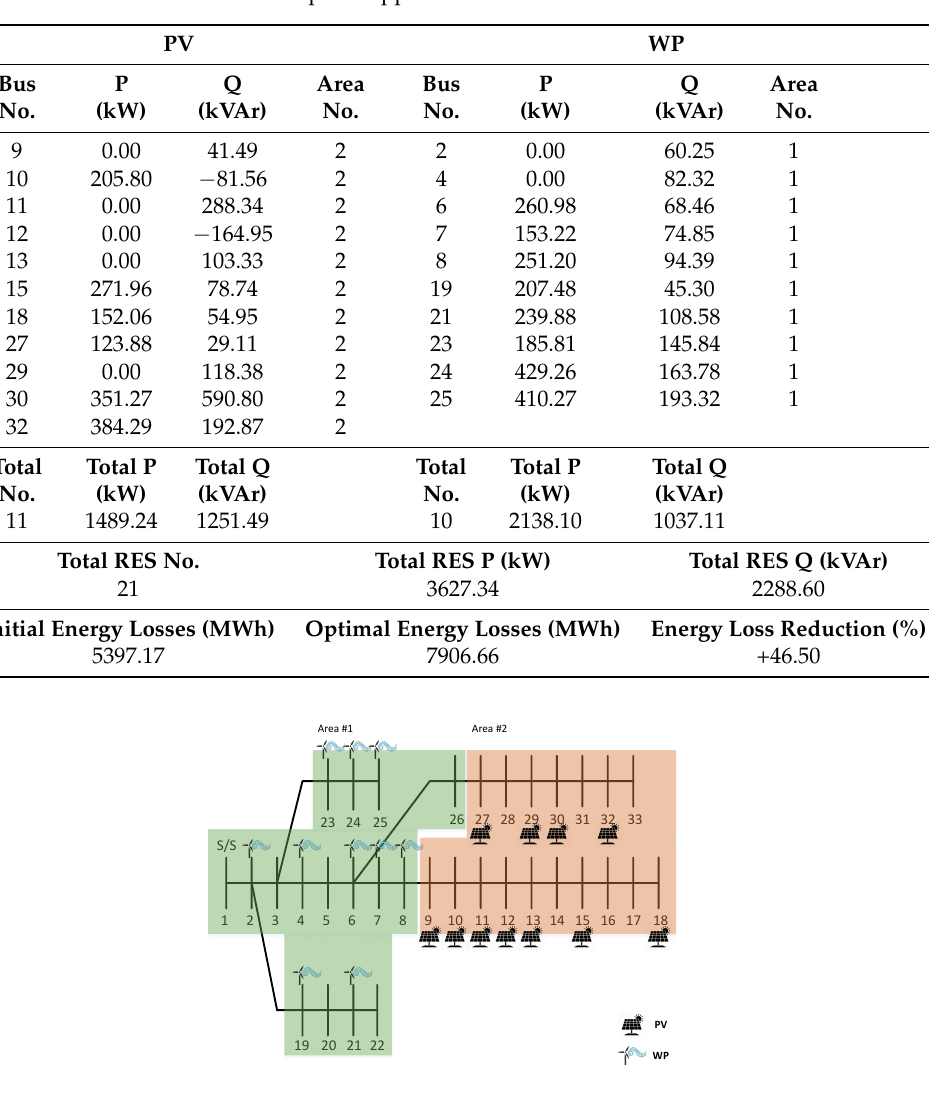
Figure 23. Snapshot Approach—Max Value—Scenario #2